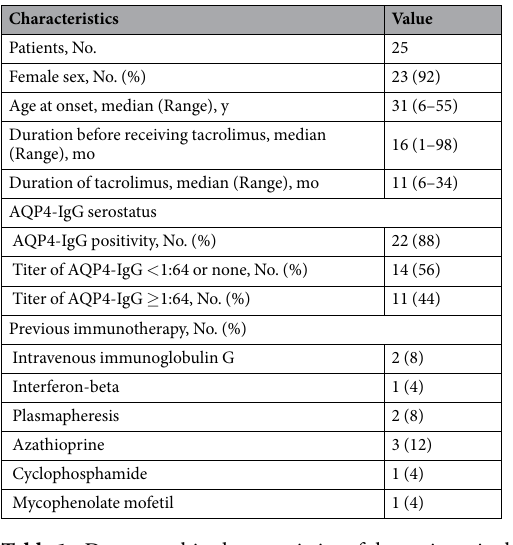
Table 1. Demographic characteristics of the patients included. AQP4-IgG: aquaporin 4 immunoglobulin G.